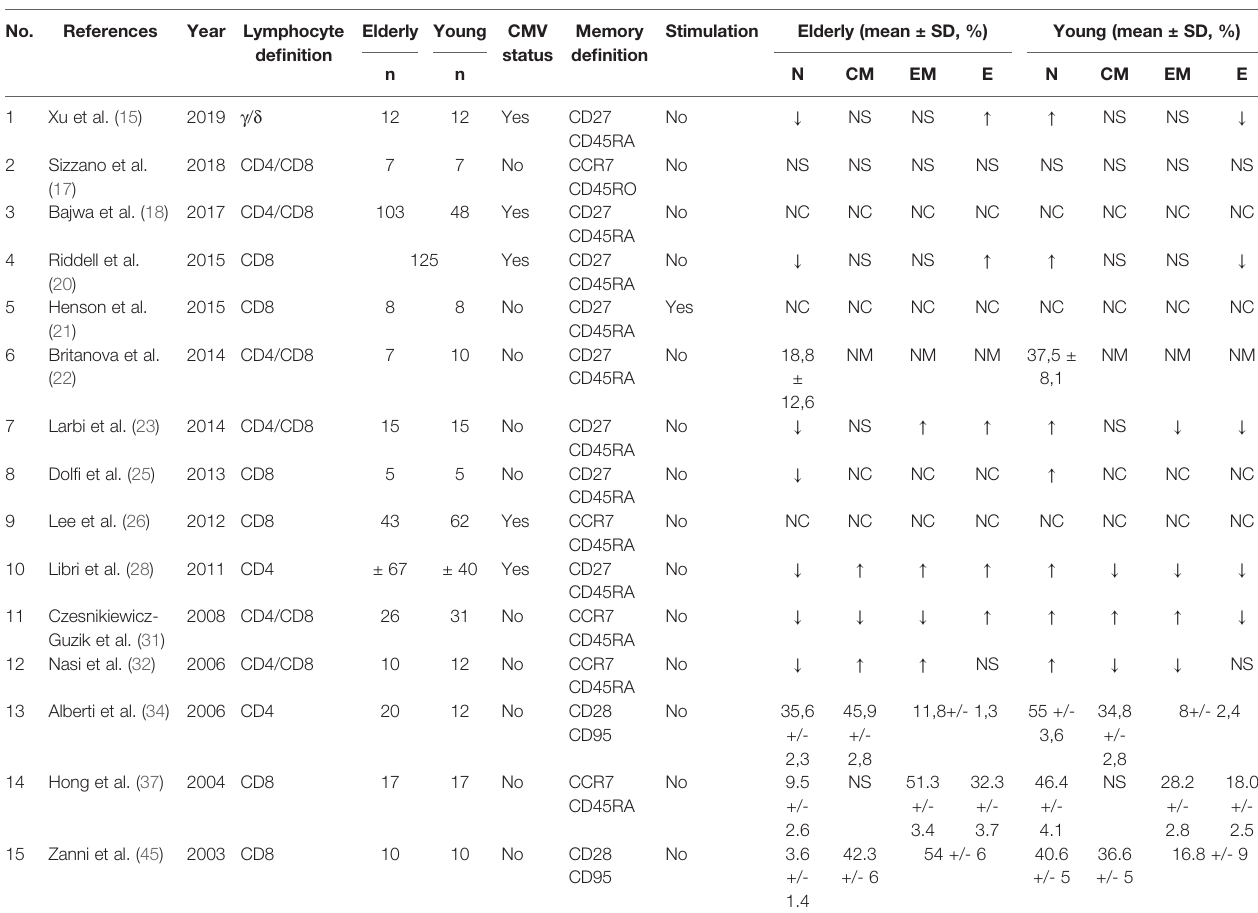
TABLE 1 | Characteristics of studies reporting memory